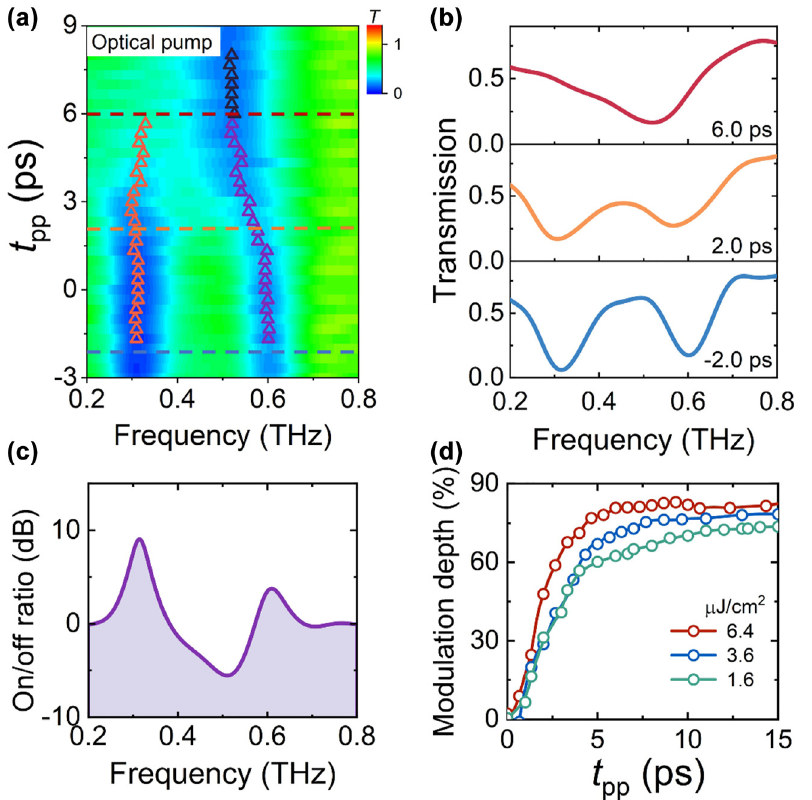
Figure2: Ultrafastmodeswitchingtriggered by optical pump. (a) Mapping of measured transmitted spectra as a function of t pp at optical pump fluence of 6.4 μ J/cm 2 . The resonance frequency is marked with triangles. (b) Measured THz transmission = − 2.0, 2.0, and 6.0 ps, spectra at t pp corresponding to the dashed lines marked in (a). (c) Measured on/off ratios as a function of frequency at 4 K at optical pump fluence of 6.4 μ J/cm 2 . (d) Measured modulation depth underdifferent at0.32THzasafunctionof t pp pump intensities. The mode switching yields a large on/off ratio, which is a crucial indicator for the THz modulator. The on/off / T ), where T and ratio ( 𝜅 ) is defined as 𝜅 = 10 ∙ log( T on off on T are the transmission coefficients before and after mode off switching, respectively. Using the measured transmission =− 2.0psand6.0ps,wecalculatedtheon/off spectraat t pp ratio spectra as shown in Figure 2(c). The highest value is approximately 9 dB at 0.32 THz for the CTP resonance mode. The on/off ratio is as high as 6 dB at 0.51 THz for the BDP mode and 4 dB at 0.61 THz for the SBDP